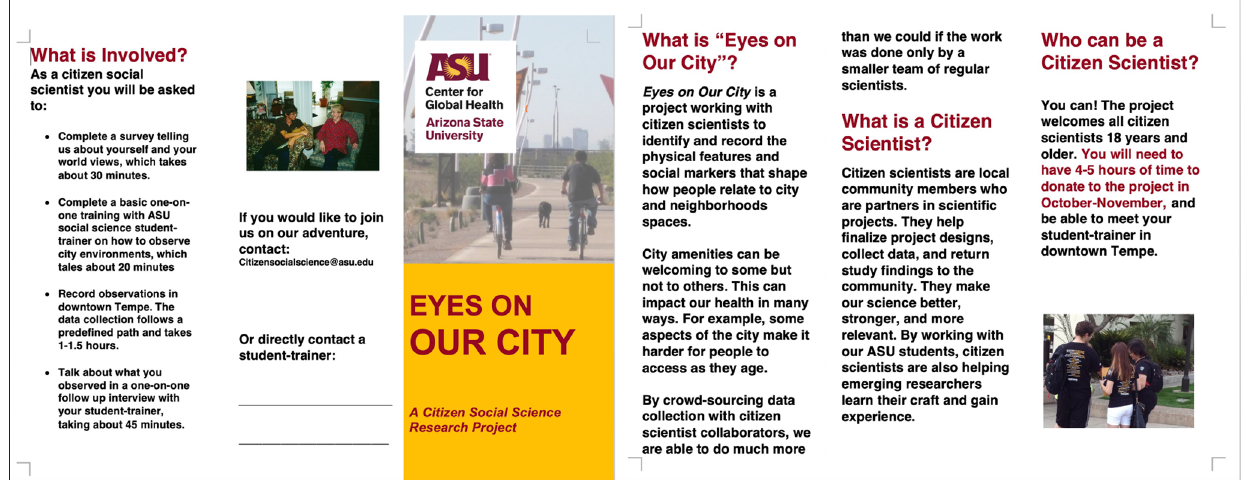
Figure 1 Recruitment brochure for citizen social science project “Eyes on OUR